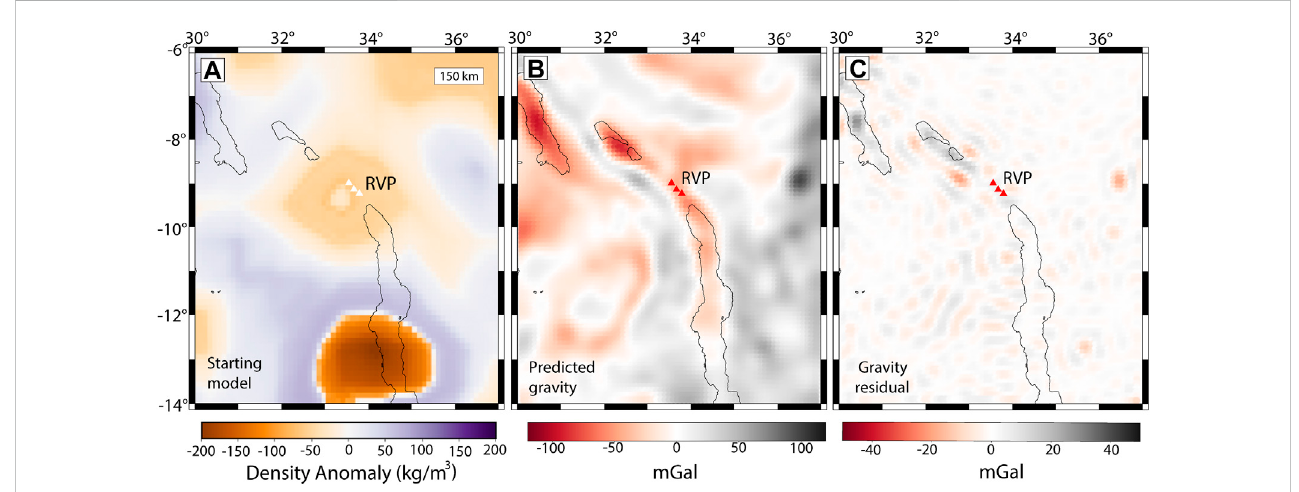
FIGURE 7 (A) 150 km depth slice of the resultant density anomaly beneath the Rungwe Volcanic Province and surroundings derived from constrained inversion of gravity datawith shear-wave velocityperturbations fromEmry etal. (2019) as reference model. (B) The predicted gravity calculated fromourresultant density anomaly. (C) Residualgravity,whichisthedifferencebetweentheobservedgravityanomalies(Figure2)andthepredictedgravityanomaly(Figure7B)showing a good fi t between the predicted and observed gravity data. RVP = Rungwe Volcanic Province. White and red triangles represent the RVP. Black lines indicate the outline of rift